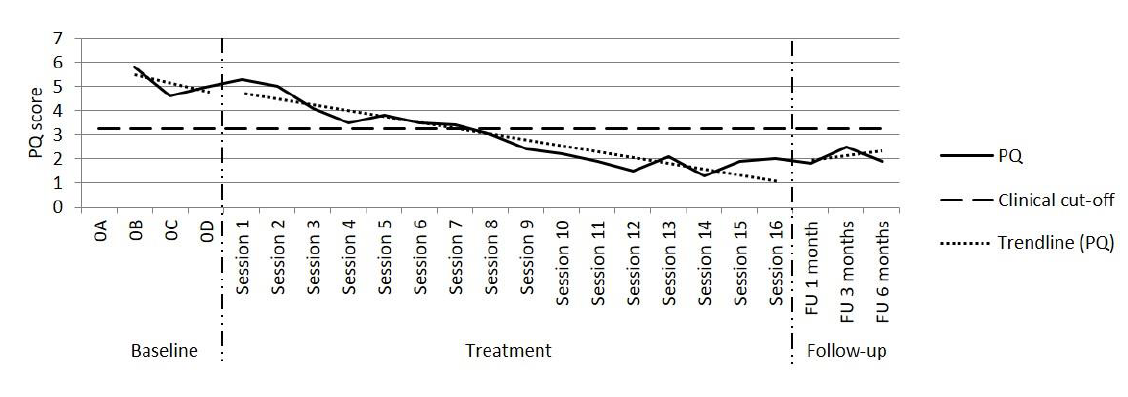
Figure 3: Margherita’s weekly global distress (CORE) score